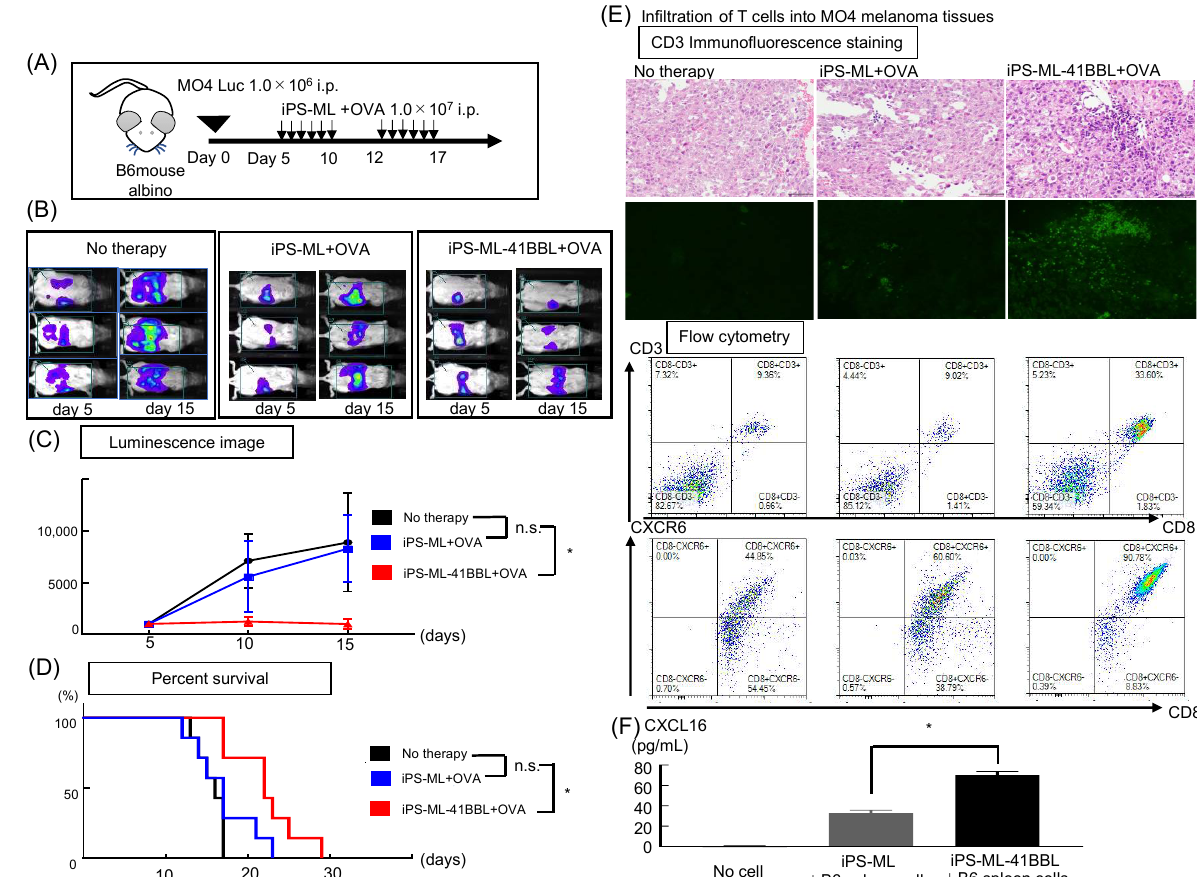
Figure 2. Effects of iPS-ML-41BBL against MO4 melanoma in vivo. ( A ) The model of treatment schedule; luciferase-expressing MO4 cells are intraperitoneally injected into B6-albino mice (1.0 × 10 6 cells/mouse). After 5 days, the mice were randomly divided into control ( n = 8), OVA peptide-pulsed iPS-ML ( n = 8), and OVA peptide-pulsed iPS-ML-41BBL ( n = 8) treatment groups. The mice in the OVA peptide-pulsed iPS-ML or OVA peptide-pulsed iPS-ML-41BBL groups were injected with 1 × 10 7 cells/mouse/injection on days 5–10 and 12–17. ( B ) Luminescence images showing tumor growth. ( C ) Plots showing fold change in tumor-associated luminescence from day 5. ( D ) The Kaplan-Meier plot of the overall survival and median survival time (MST). * p < 0.05. ( E ) Infiltration of T cells into MO4 melanoma tissues. The treatment and sampling schedule are the same as shown in Figure 2A. The immunofluorescence staining was analyzed using a fluorescence microscope BZ-X700. T cell marker CD3 was stained by Alexa Fluor 488. FCM analysis of dissociated cells obtained from tumor tissues harvested on day 18. ( F ) The sampling schedule is the same as that shown in Figure 1C. Effects of iPS-ML expressing CXCL16 on no cells, iPS-ML, and iPS-ML-41BBL. Expression levels of CXCL16 were analyzed using ELISA. n.s. = not significant, * p <